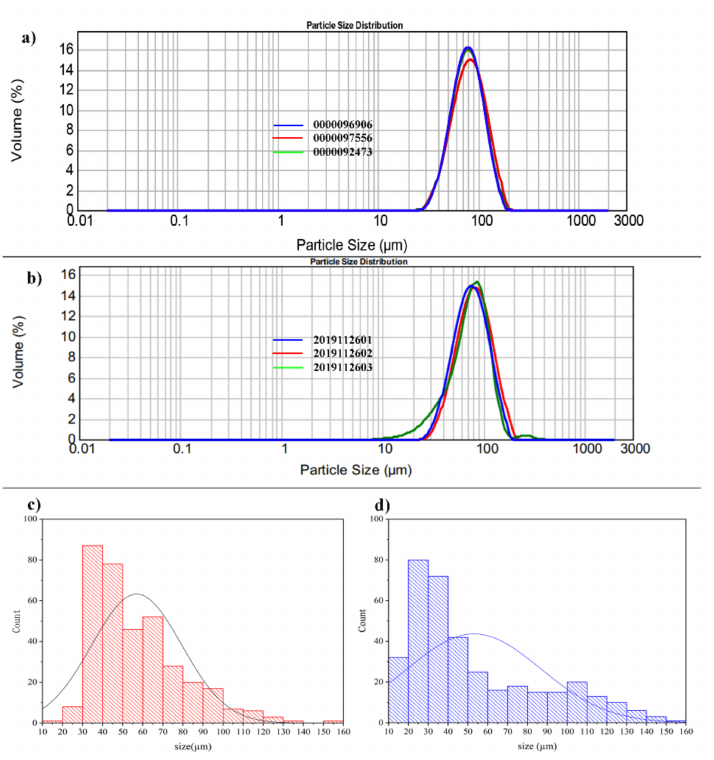
Figure 4. Particle size distribution of Vivitrol ® and the GNM. The laser-diffraction ( a ) and ( b ) and the microscope method ( c ) and ( d ) were both used to detect the particle-size distribution of Vivitrol ® and the